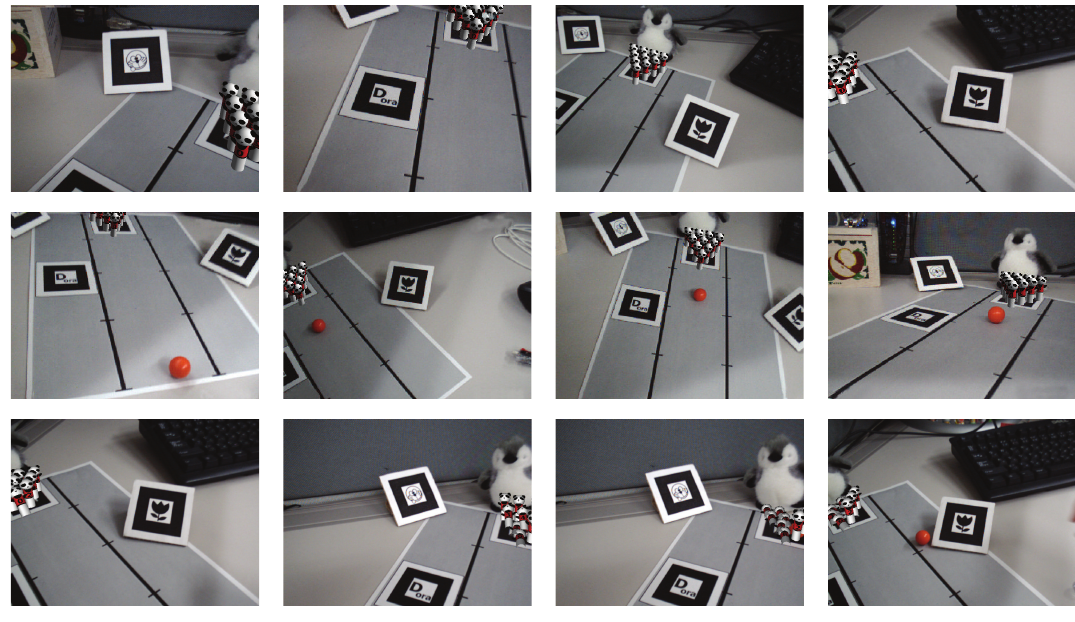
Figure 19: Resulting images on which virtual pins are overlaid.